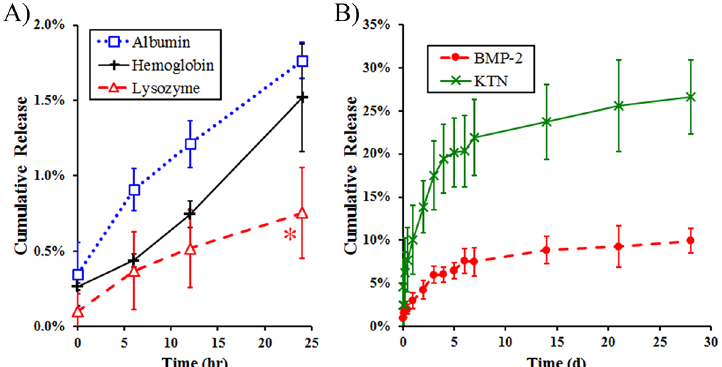
Fig 9. Rates of release of proteins out of bulk KTN gels. A) Globular proteins diffused out of gels in the following order: negatively-charged albumin, neutral hemoglobin, and positively-charged lysozyme. At the 24-hr time point, the amount of lysozyme released was significantly lower ( * p < 0.01) compared to that of albumin and hemoglobin. B) BMP-2 had a slow release profile in PBS (pH 7.4) medium, suggesting tight electrostatic association with the KTN matrix and BMP-2 intermolecular aggregation due to the salting-out effect. KTN bulk degradation was faster relative to the BMP-2